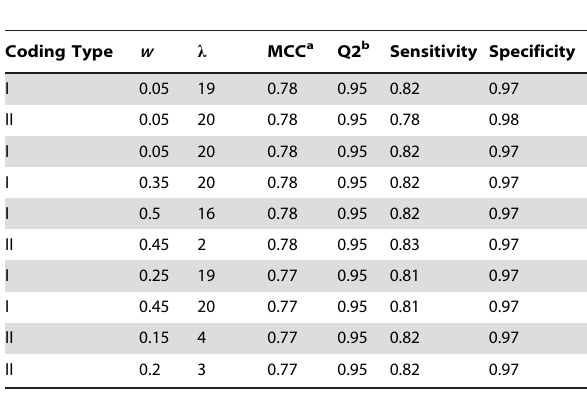
Table 1. Prediction performance of Presep with different